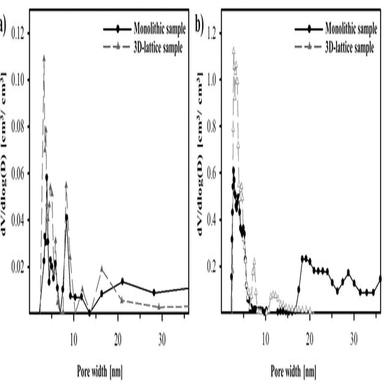
Pore size distribution obtained from N2 adsorption isotherms applying the a) BJH theory and b) the DFT.